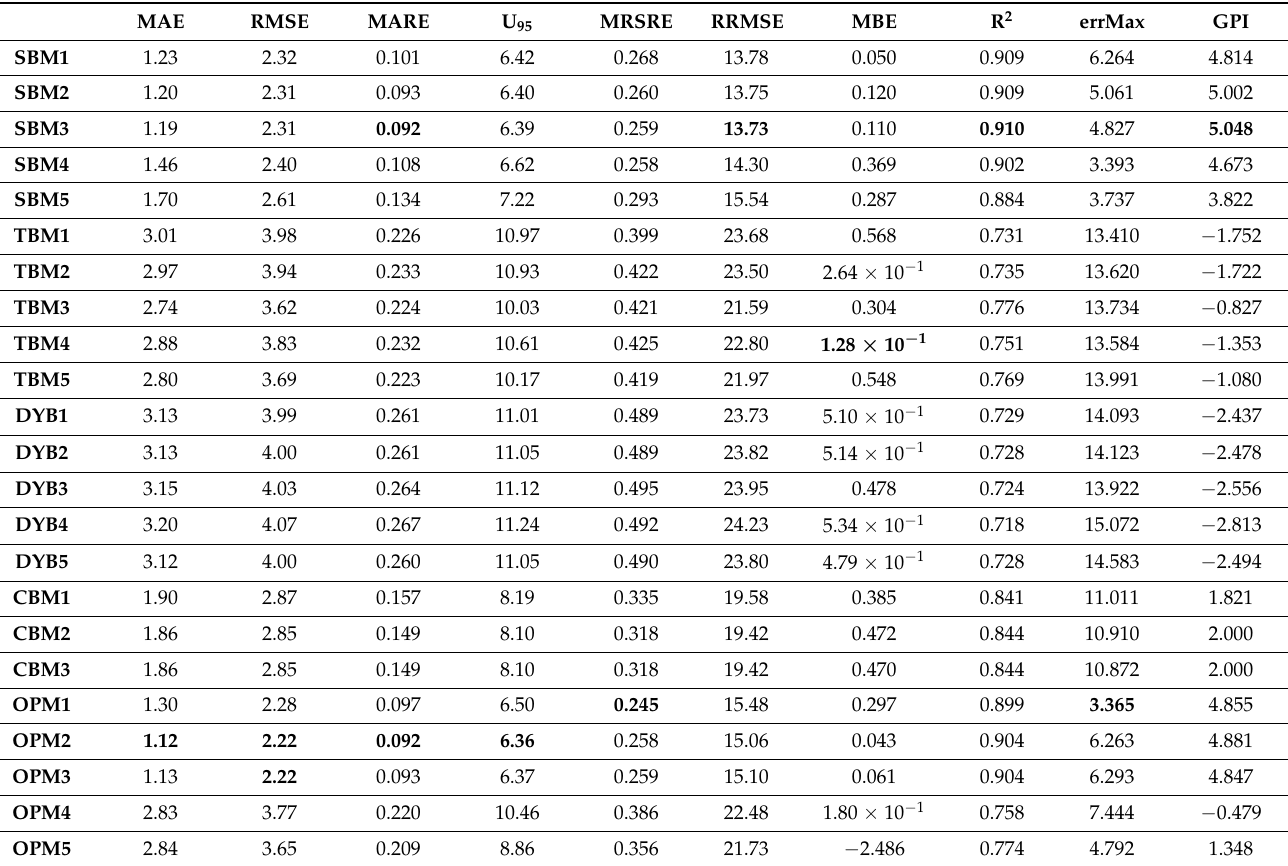
Table 9. Statistical indicators for the empirical models. The most accurate scores are highlighted in bold